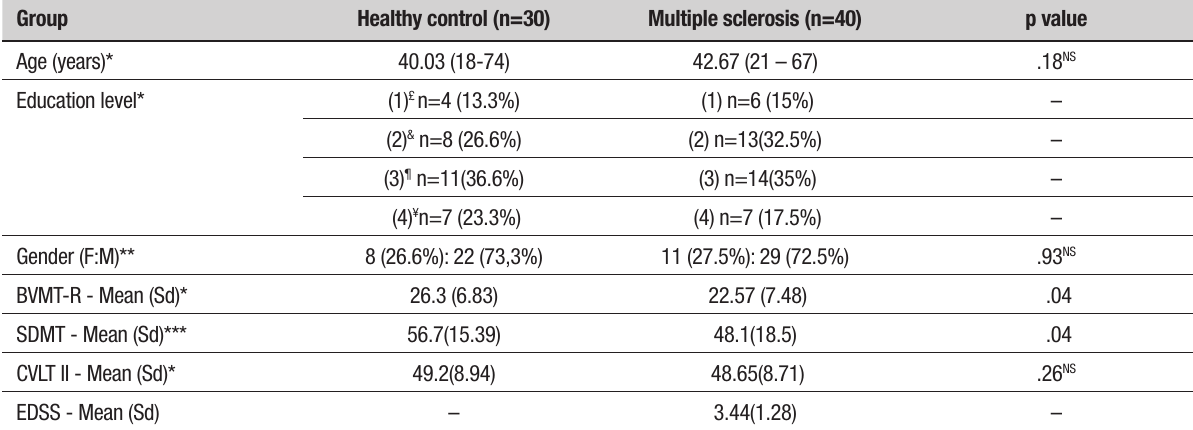
Table 1. Demographic data of sample and BVMT-R